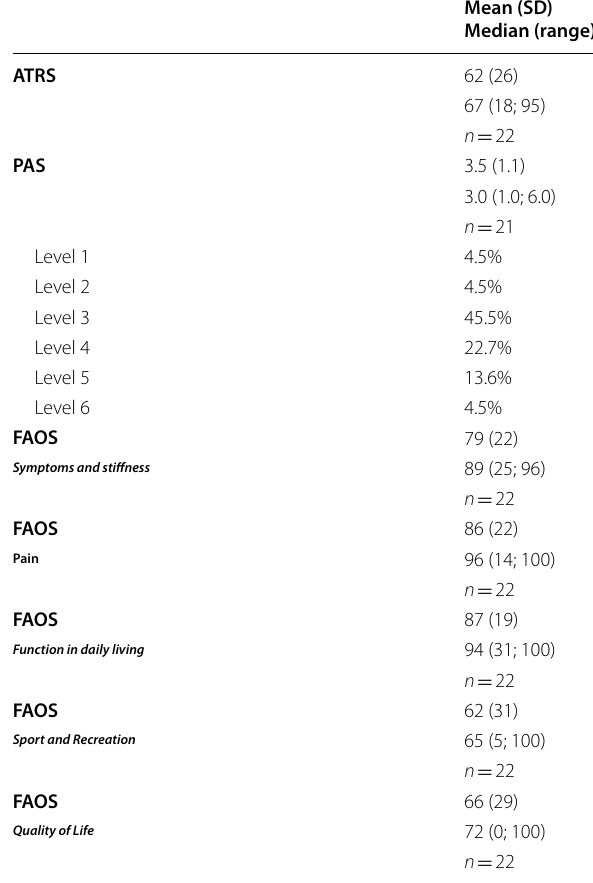
AATR Acute Achilles Tendon Rupture, CATR Chronic Achilles Tendon Rupture, ATRS Achilles tendon total rupture score, PAS Physical activity scale, FAOS Foot and ankle outcome score, N/A not available, * small effect, ** medium effect, *** large